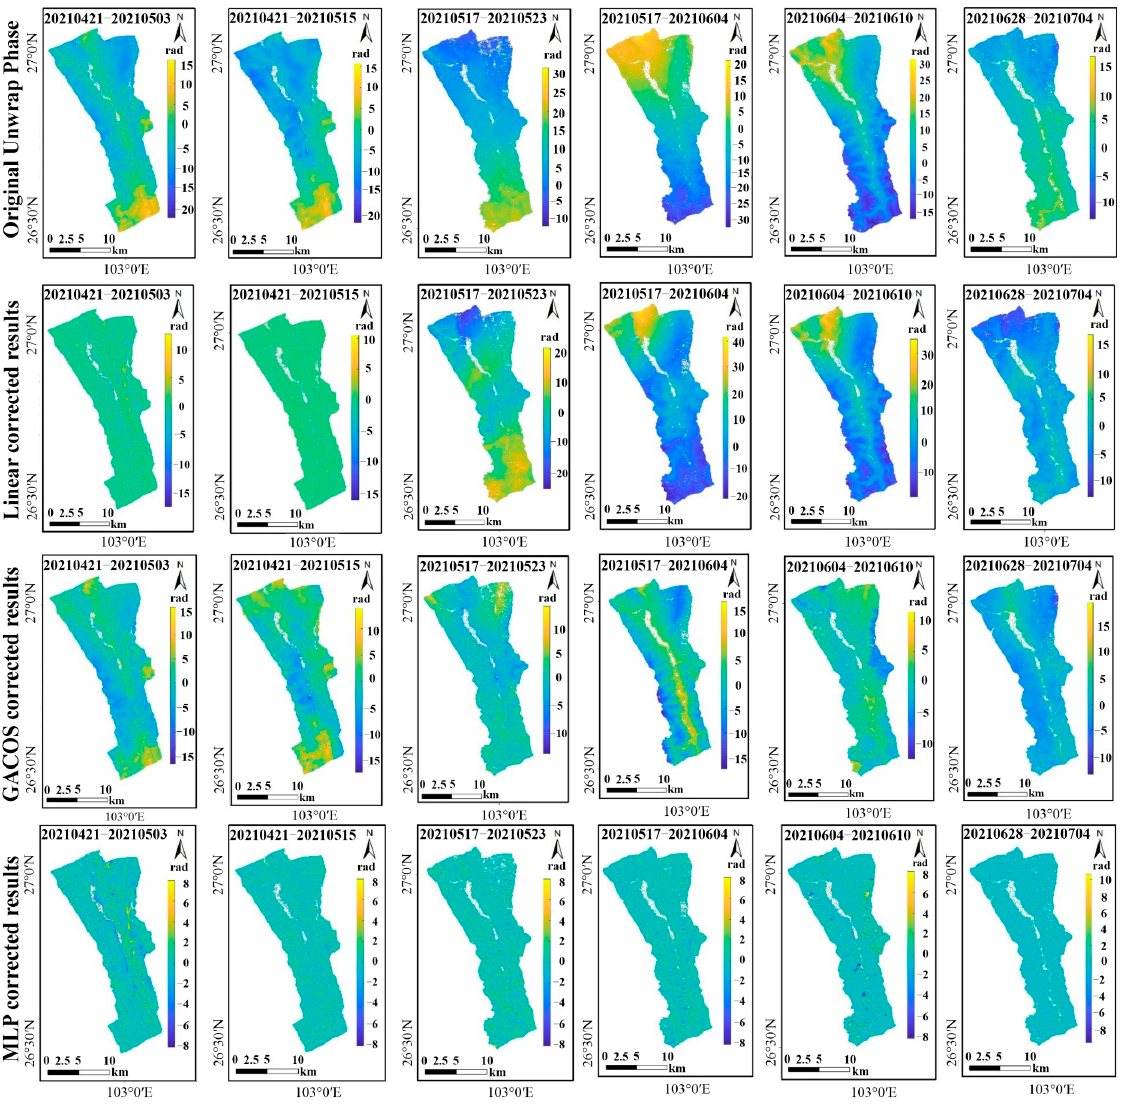
Figure 4. The correction effects of three topography-dependent atmospheric delay correction methods on InSAR interferograms.